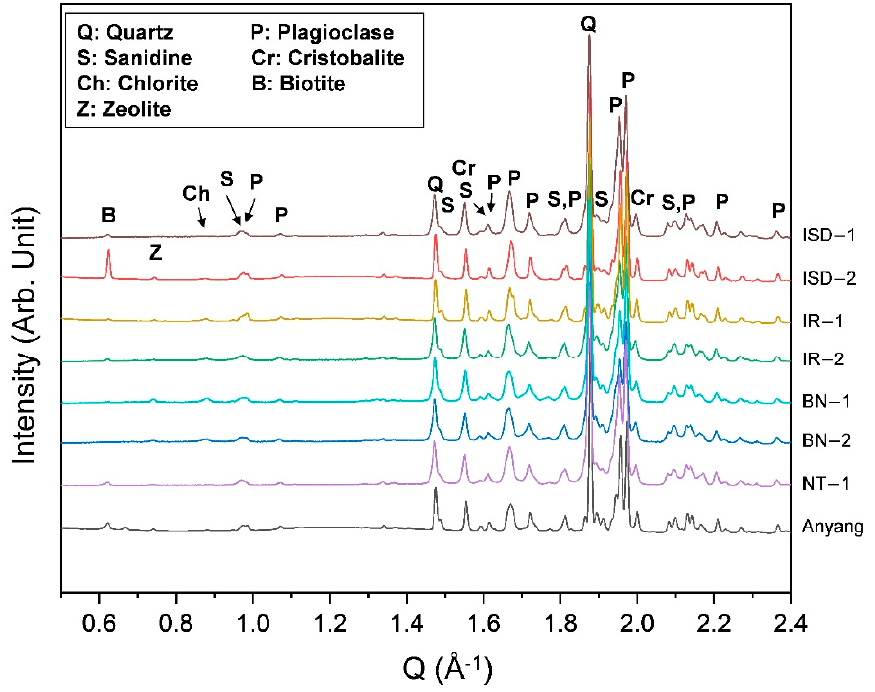
Figure 4. High ‐ resolution synchrotron X ‐ ray powder diffraction patterns of the Mudeungsan tuff